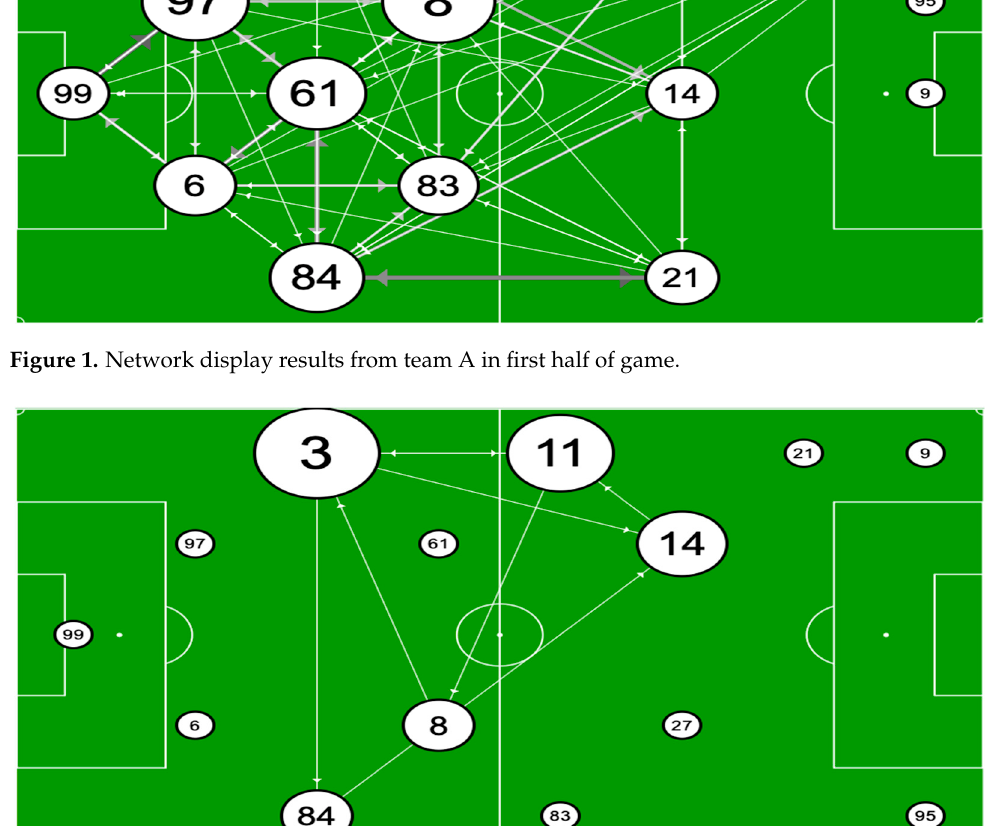
Figure 2. Network display results from team A in the critical event B4.